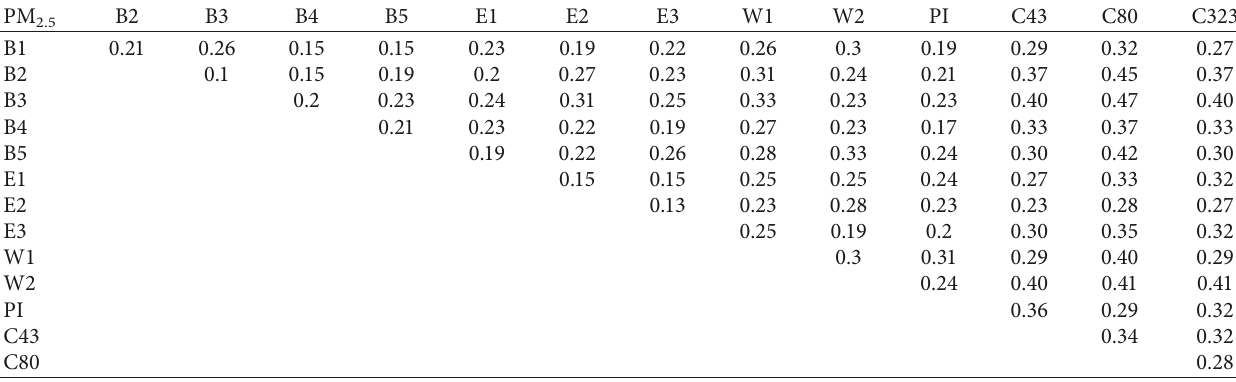
Table 3: PM 2.5 COD values between the study locations and the CAMS sites.